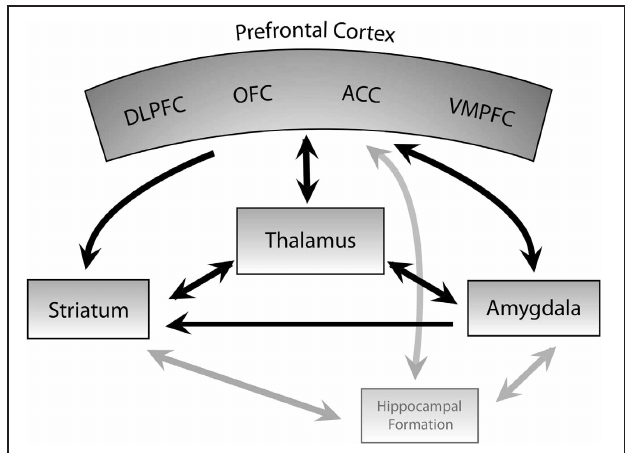
FIGURE 1 | Cortico-striato-thalamocortical circuit. Schematic diagram of the cortico-striato-thalamocortical (CSTC) circuit, which is implicated in the pathophysiology of OCD. In DBS for OCD, activity within this circuit is thought to be modulated by high frequency stimulation. DLPFC, dorsolateral prefrontal cortex; ACC, anterior cingulate cortex; OFC, orbitofrontal cortex; VMPFC, ventromedial prefrontal cortex. Arrowheads indicate direction of neural input. Black lines represent connections among the major structures implicated in DBS for OCD; gray lines indicate additional